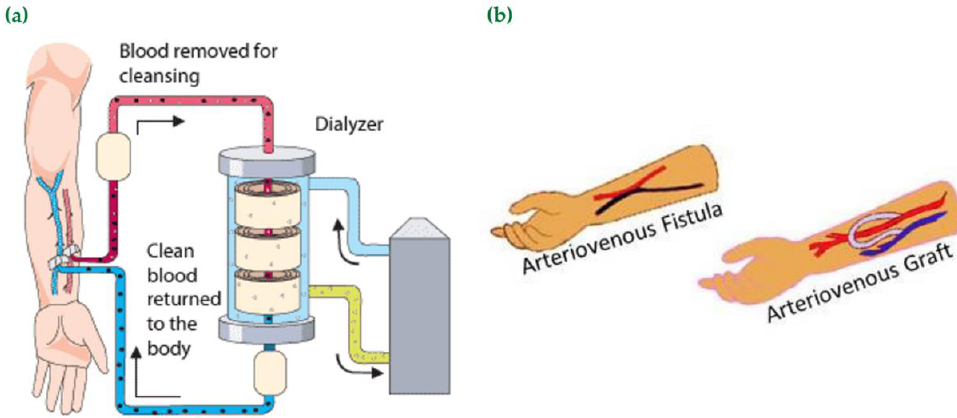
Figure 1. ( a ) Working principle of hemodialysis treatment and hemodialysis machine; ( b ) type of arteriovenous shunt (AVF and AVG).